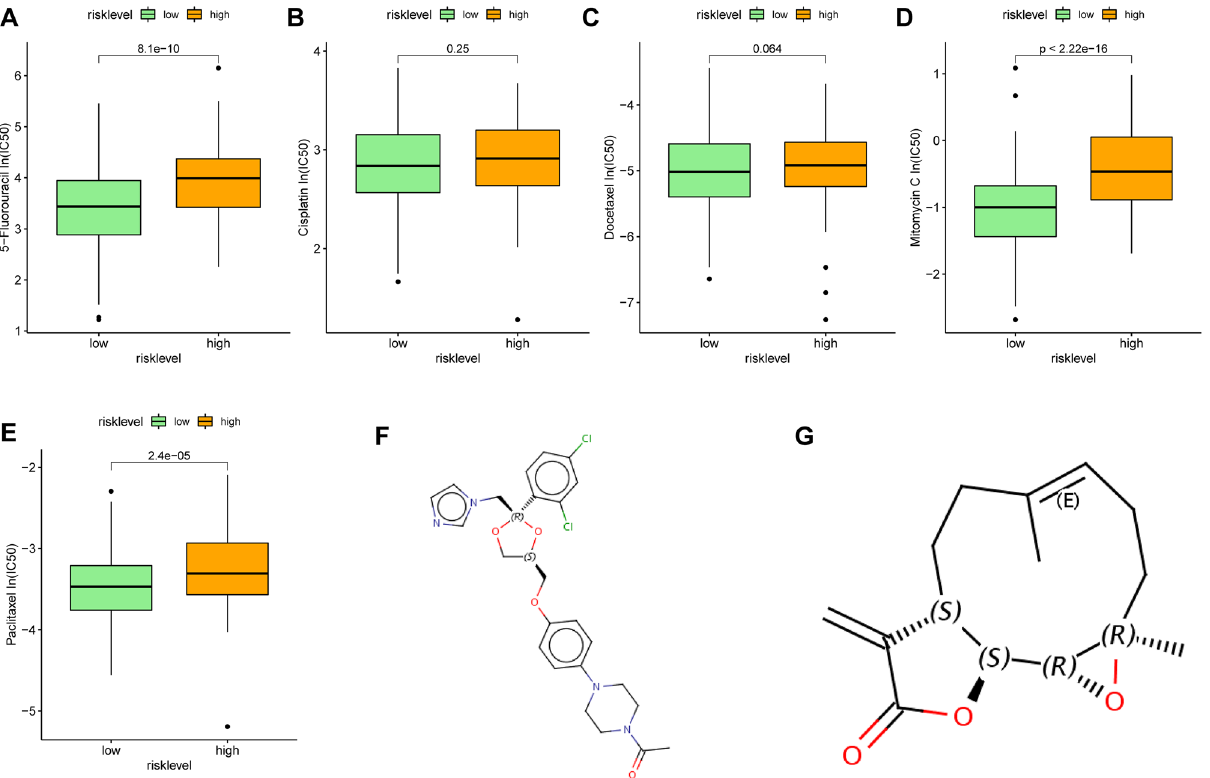
Figure 5. The estimation of chemotherapy response and potential therapeutic drugs for gastric cancer. ( A–E ) The chemotherapy response of two metabolic subtypes for 5 common chemotherapy drugs. ( F,G ) The molecular structure of the 2 small-molecule drugs for gastric cancer (F, ketoconazole; G,